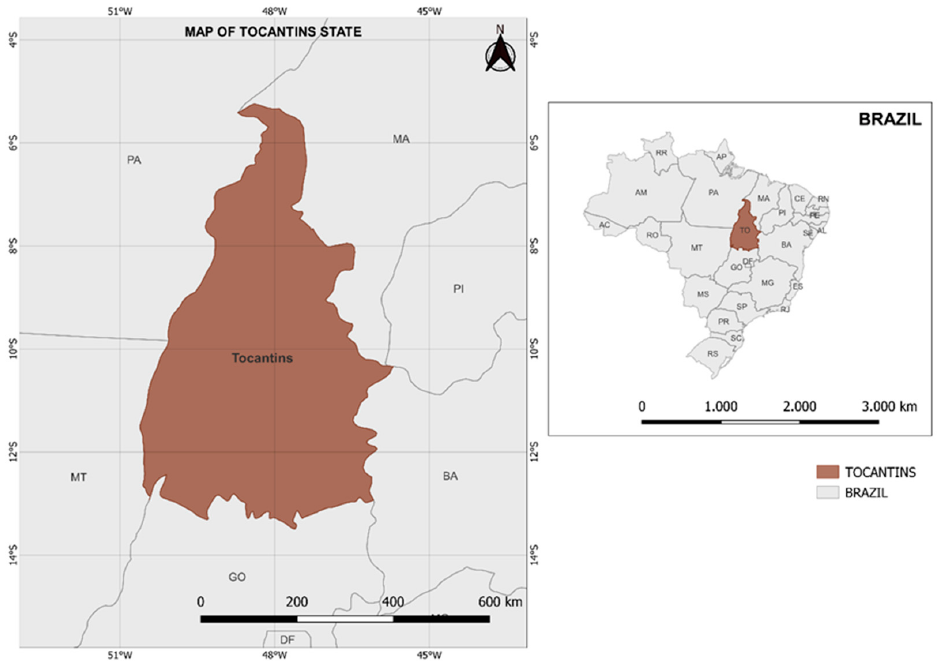
Figure 1. State map of Brazil with emphasis on Tocantins state. This figure was generated using QGIS v 3.20.2-Odense (Quantum Geographic Information System, QGIS Application Network Connections, Saint-Pierre, La Réunion, France).